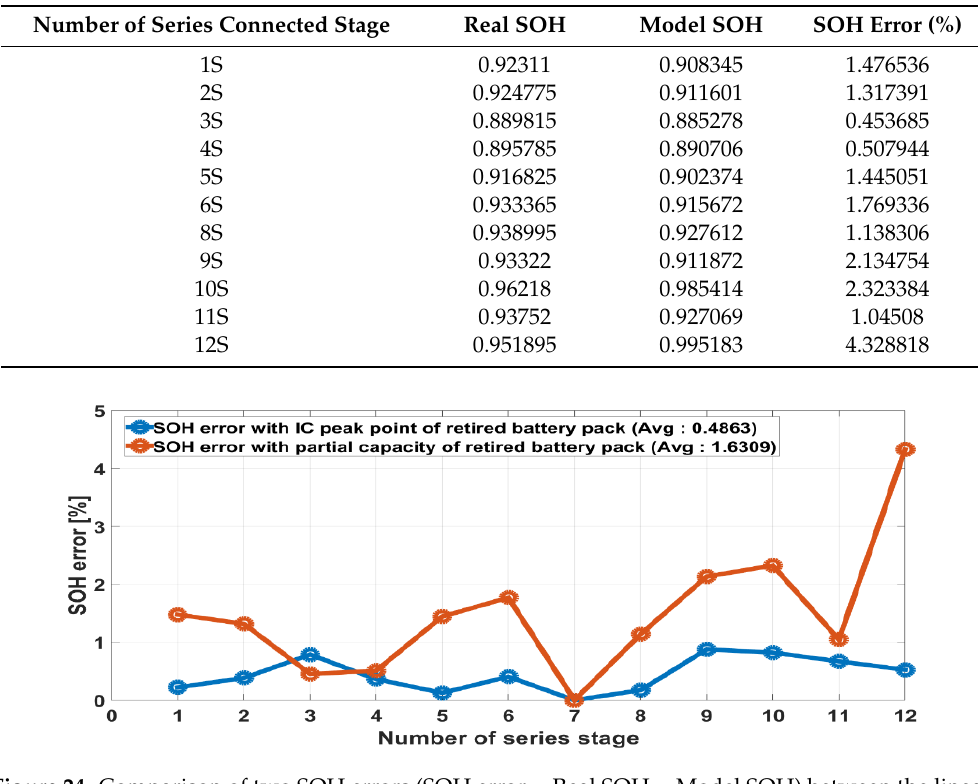
Figure 24. Comparison of two SOH errors (SOH error = Real SOH − Model SOH) between the linear regression model SOH (cell no. 1) and a real SOH (12 series-connected stages of the retired series/parallel battery pack) considering the IC curve peak point and partial capacity. Table 3. Numerical results for comparing between the linear regression model based on the IC curve peak point of cell no.1 and a real SOH for the IC curve peak point of the 12 series ‐ connected stages of